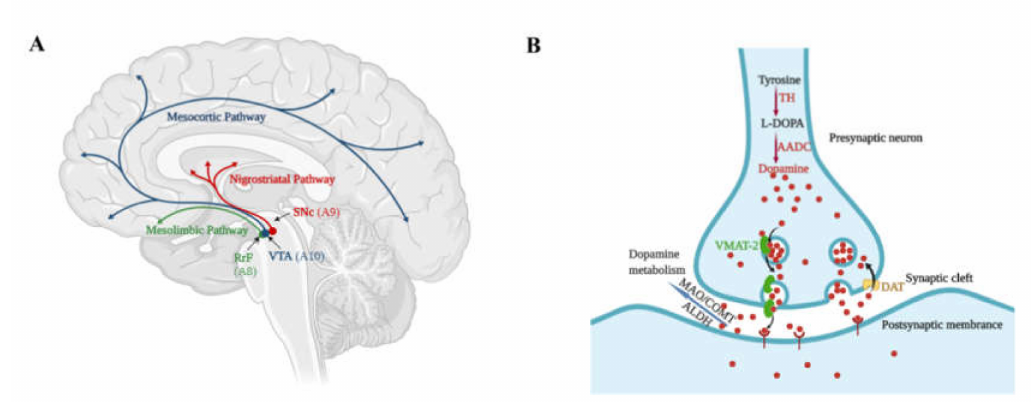
Figure 1. Dopamine pathway and dopamine neurotransmitters in the brain: ( A ) Dopaminergic pathways in the brain. mDA neurons are located in three distinct nuclei, the retrorubral field (RrF or A8 area), the substantia nigra pars compacta (SNc or A9 area), and the ventral tegmental area (VTA or A10 area). SNc mDA neurons project to the dorsal striatum via the nigrostriatal pathway. The VTA and RrF mDA neurons project to ventral striatum and prefrontal cortex forming the mesocortical and mesolimbic dopaminergic system. ( B ) The biosynthesis and metabolism of dopamine neurotransmitters. (Figures were created using